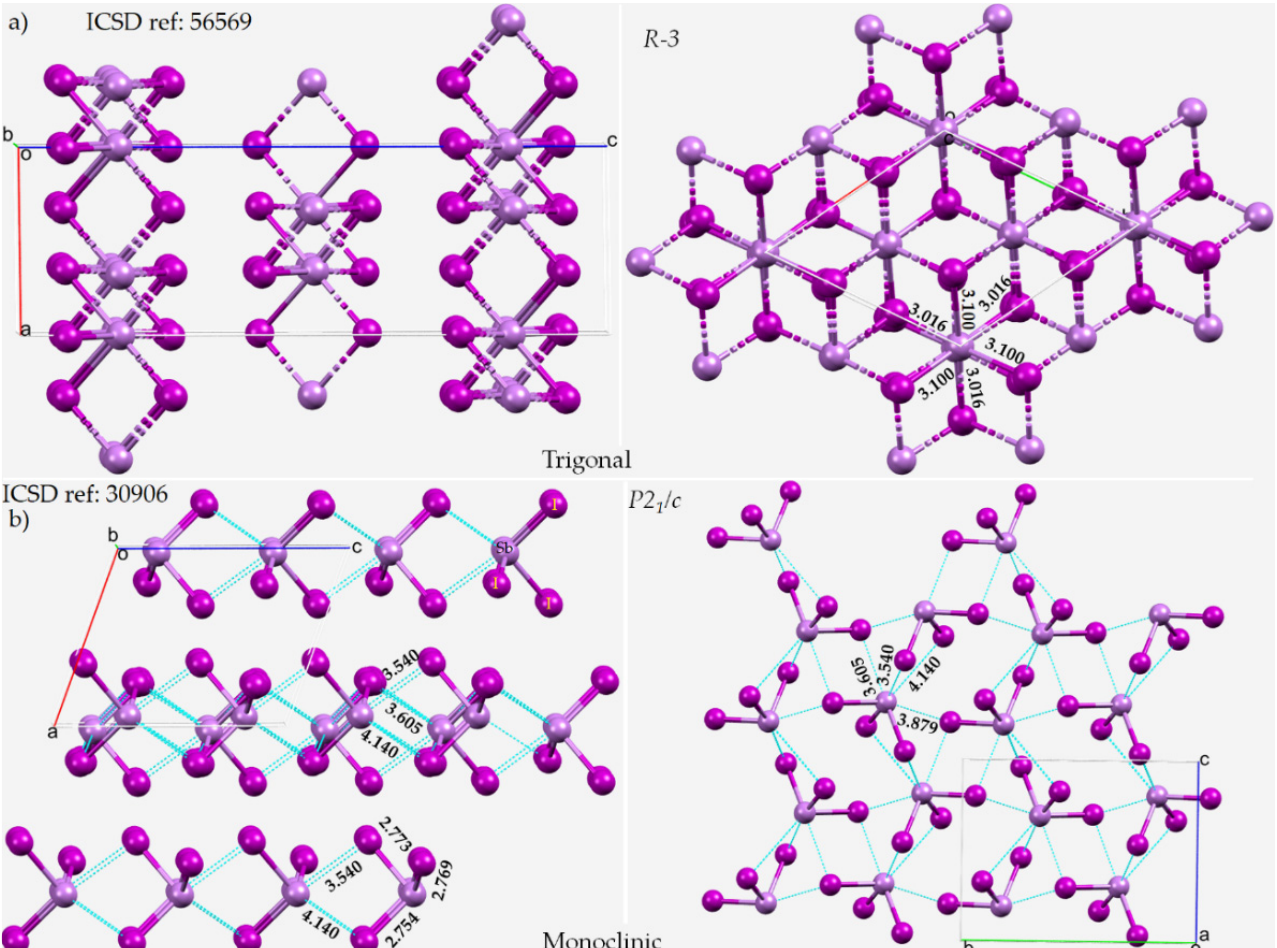
Figure 10. ( a ) The crystal structure of the R- 3 trigonal geometry of SbI 3 , showing the layer-like structure in 2D ( left ), and local octahedral coordination environment of the Sb 3+ ion. ( b ) The crystal structure of the monoclinic geometry of antimony triiodide, showing a 3D network of intermolecular interactions. Selected Sb–I/Sb···I bond distances are shown. The ICSD references are given in each case. Selected bond distances are in Å and degrees, respectively. The intermolecular pnictogen bonding interactions are illustrated as dotted lines in cyan.